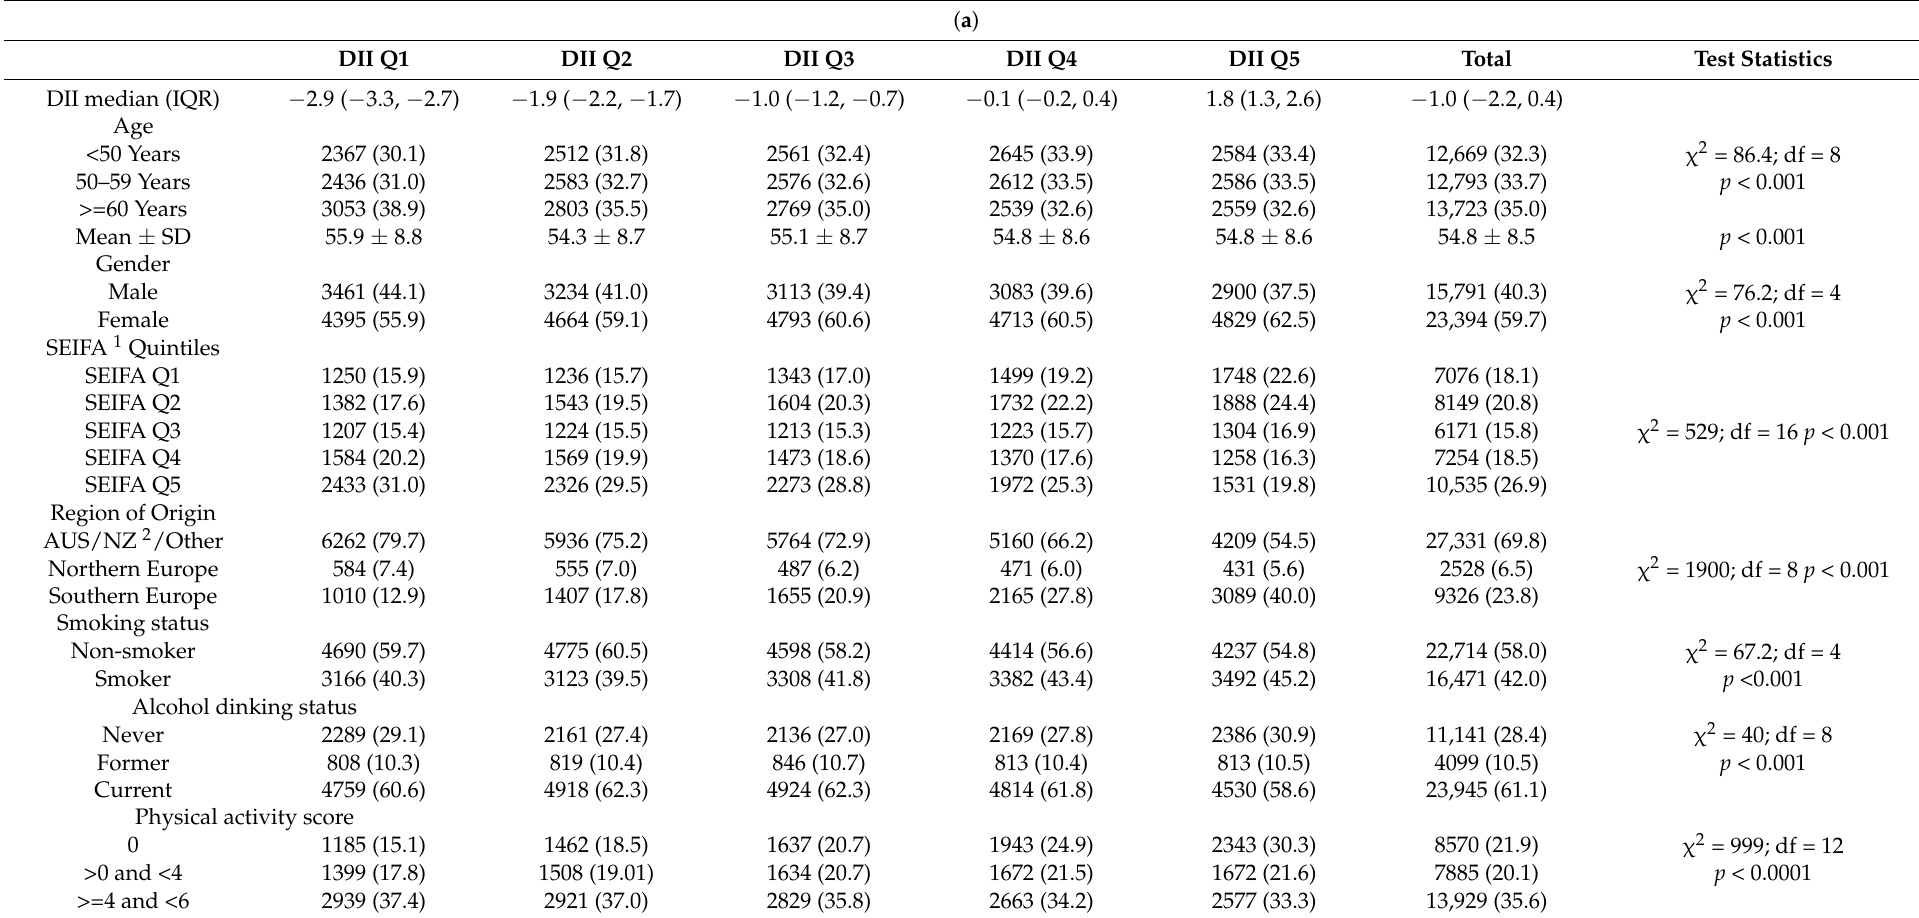
Table 1. ( a ) Descriptive statistics by Dietary Inflammatory Index (DII) quintiles. ( b ) Descriptive statistics by Alternative Healthy Eating Index-2010 (AHEI) quintiles. ( c ) Descriptive statistics by Mediterranean Diet Score (MDS)